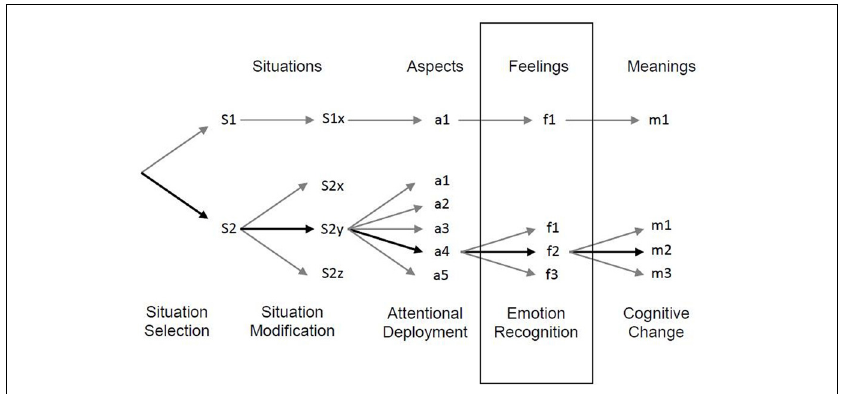
FIGURE 1 | A renewed model of the emotion regulation process, based on Gross’ model (Gross, 1998; APA, adapted with permission). This model includes only antecedent-focused strategies and suggests that emotion recognition is part of emotion regulation